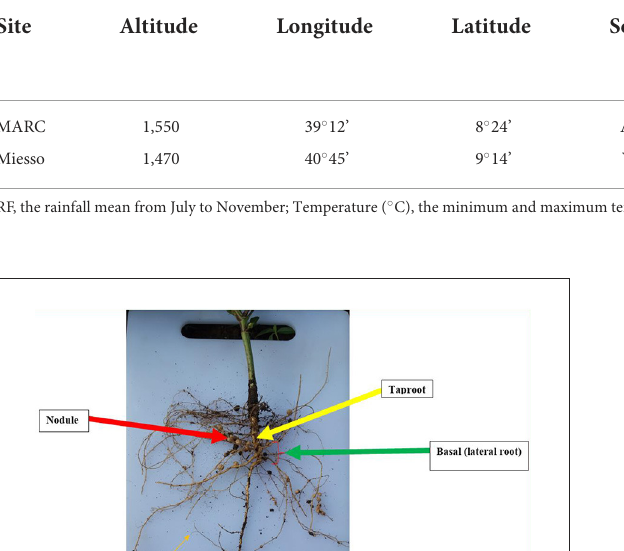
FIGURE1 Root architecture and nodule distribution of cowpea genotypes.